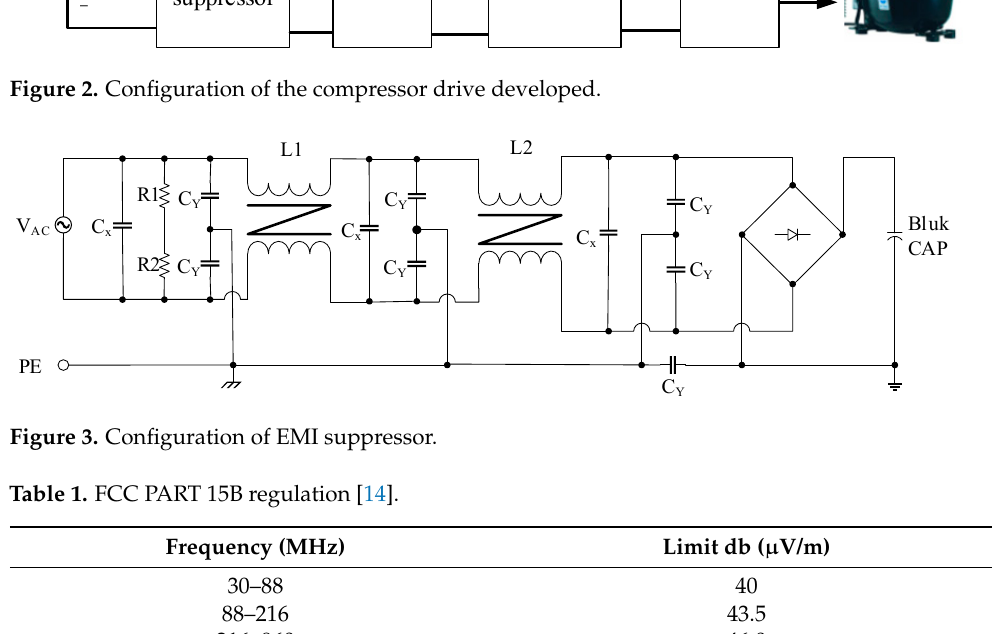
Figure 3. Configuration of EMI suppressor.